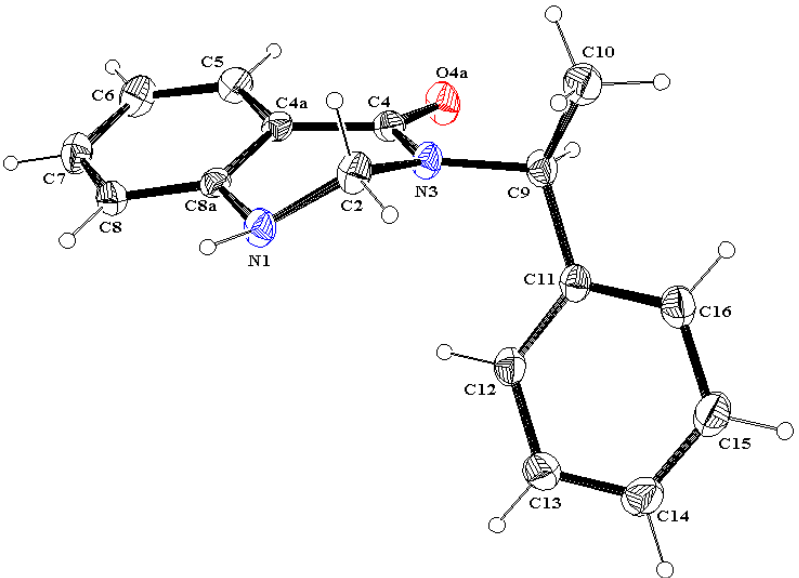
Figure 2. ORTEP drawing of compound 8 showing the syn -like conformation of carbonyl C4 and hydrogen attached to